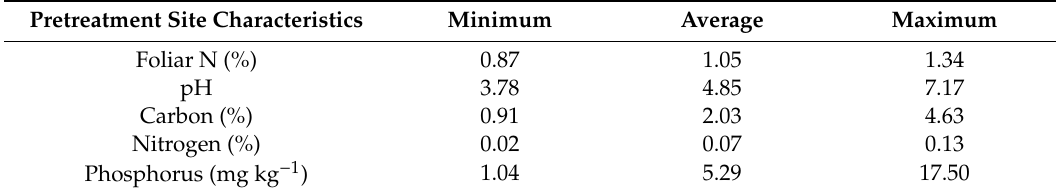
Table 2. Summary soil chemical characteristics in top 0 to 10 cm and foliar nitrogen before